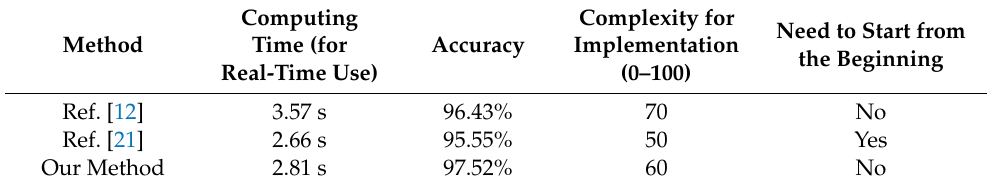
Table 1. Comparison between our proposed method and the method of two valid references. Computing Complexity for Method Time (for Accuracy Real-Time Use)